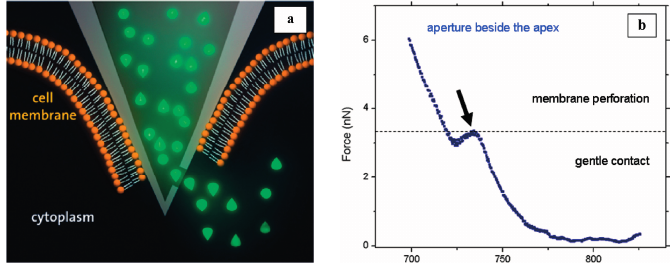
Figure 25. Intracellular injection ( a ) could be monitored by the force-distance curves ( b ) in order to control the force necessary for perforation of the cell membrane without generating a major damage. If the aperture is made beside the apex, the sharp tip is preserved, which facilitates the membrane perforation. Reprinted with permission from [25].